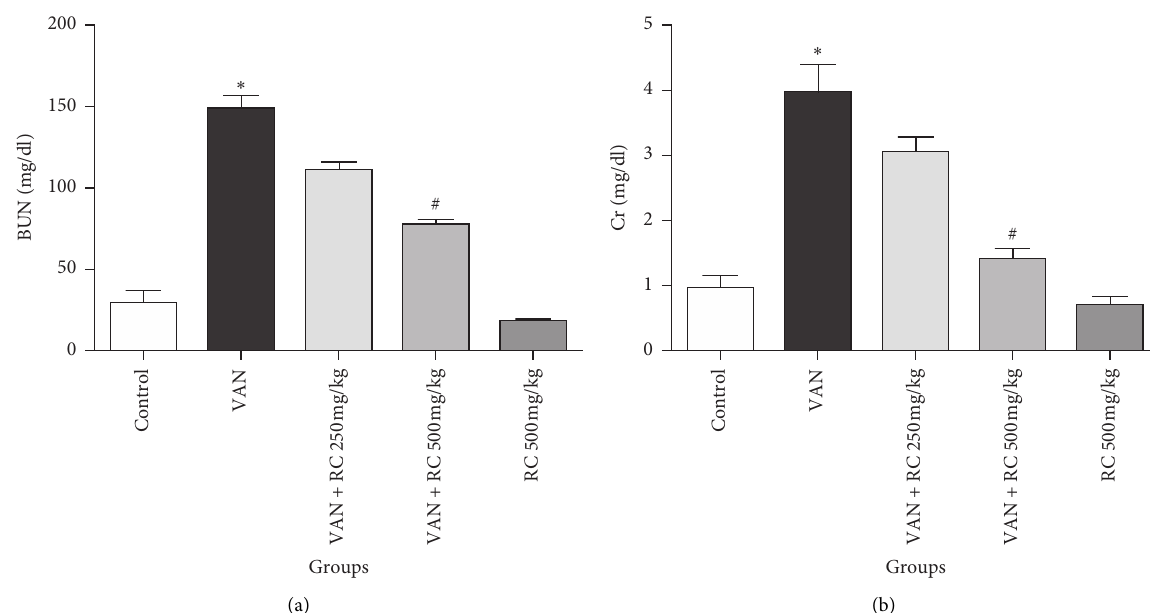
Figure 1: Effect of RC extract on kidney function markers in VAN-treated rat kidney. (a) BUN and (b) Cr. Each value represents the mean ± SEM. ∗ Statistically significant compared to the control group ( P < 0 . 05), # statistically significant compared to the VAN group ( P < 0 . 05). BUN, blood urea nitrogen; Cr, creatinine; VAN, vancomycin; RC, Rosa canina .